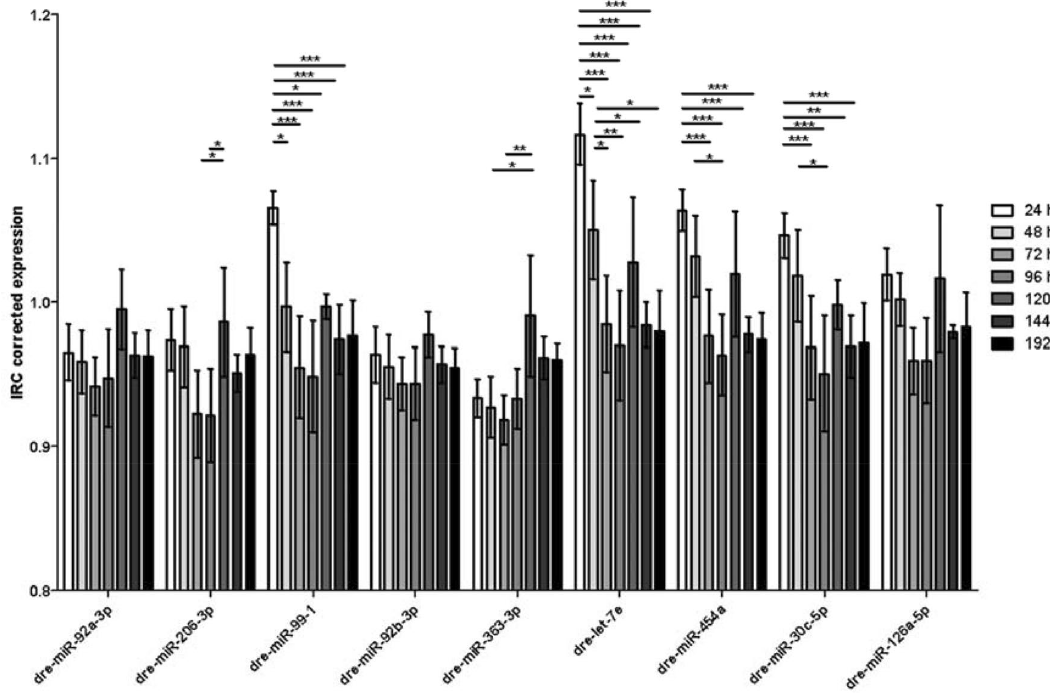
Figure 7. Differences in candidate miR expression between different developmental stages. There are no significant differences between the presented developmental stages in the expression of dre-miR-92a-3p, dre- miR-92b-3p and dre-miR-126a-5p. Data is presented as inter-run calibrator (ICR) corrected expression. All values are shown as mean from technical triplicates. *p ≤ 0.05, **p ≤ 0.01, ***p ≤ 0.001. Error bars =